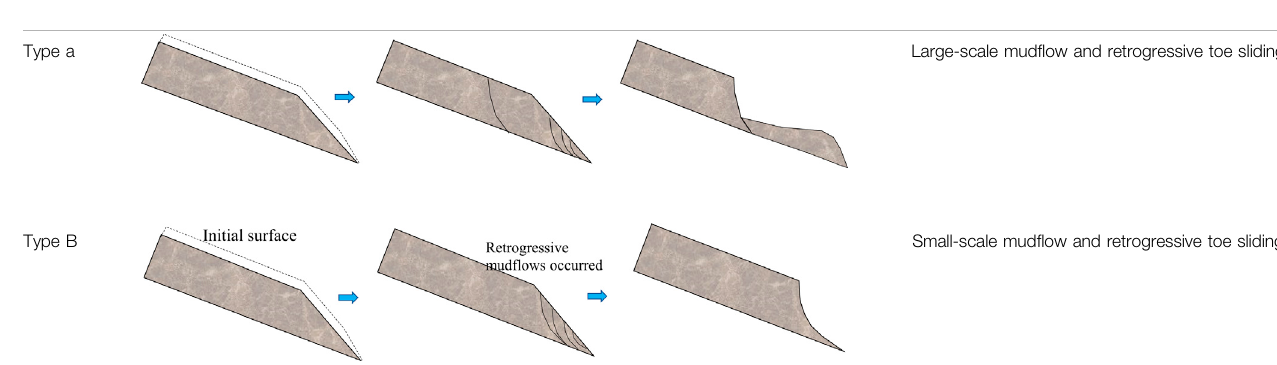
TABLE 3 | Summarized failure